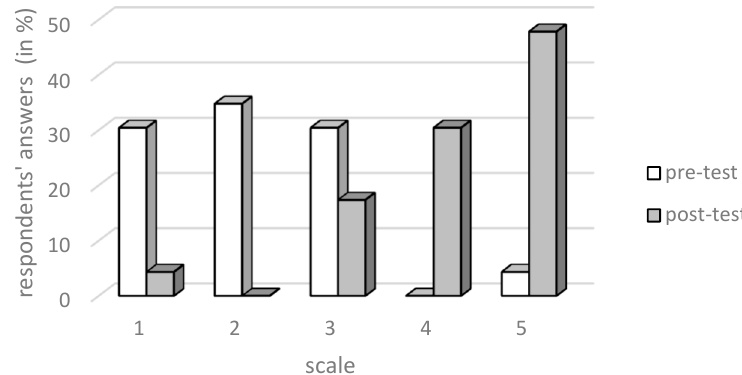
Figure 4. Respondents’ answers to question no. 1 (in %) in pre-test and post-test.